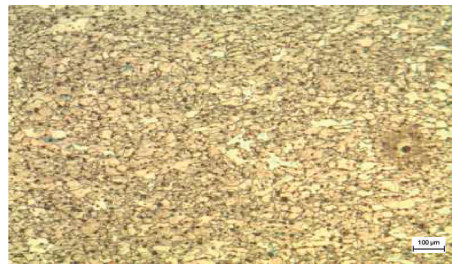
Figure 4: Microstructure analysis of HAZ